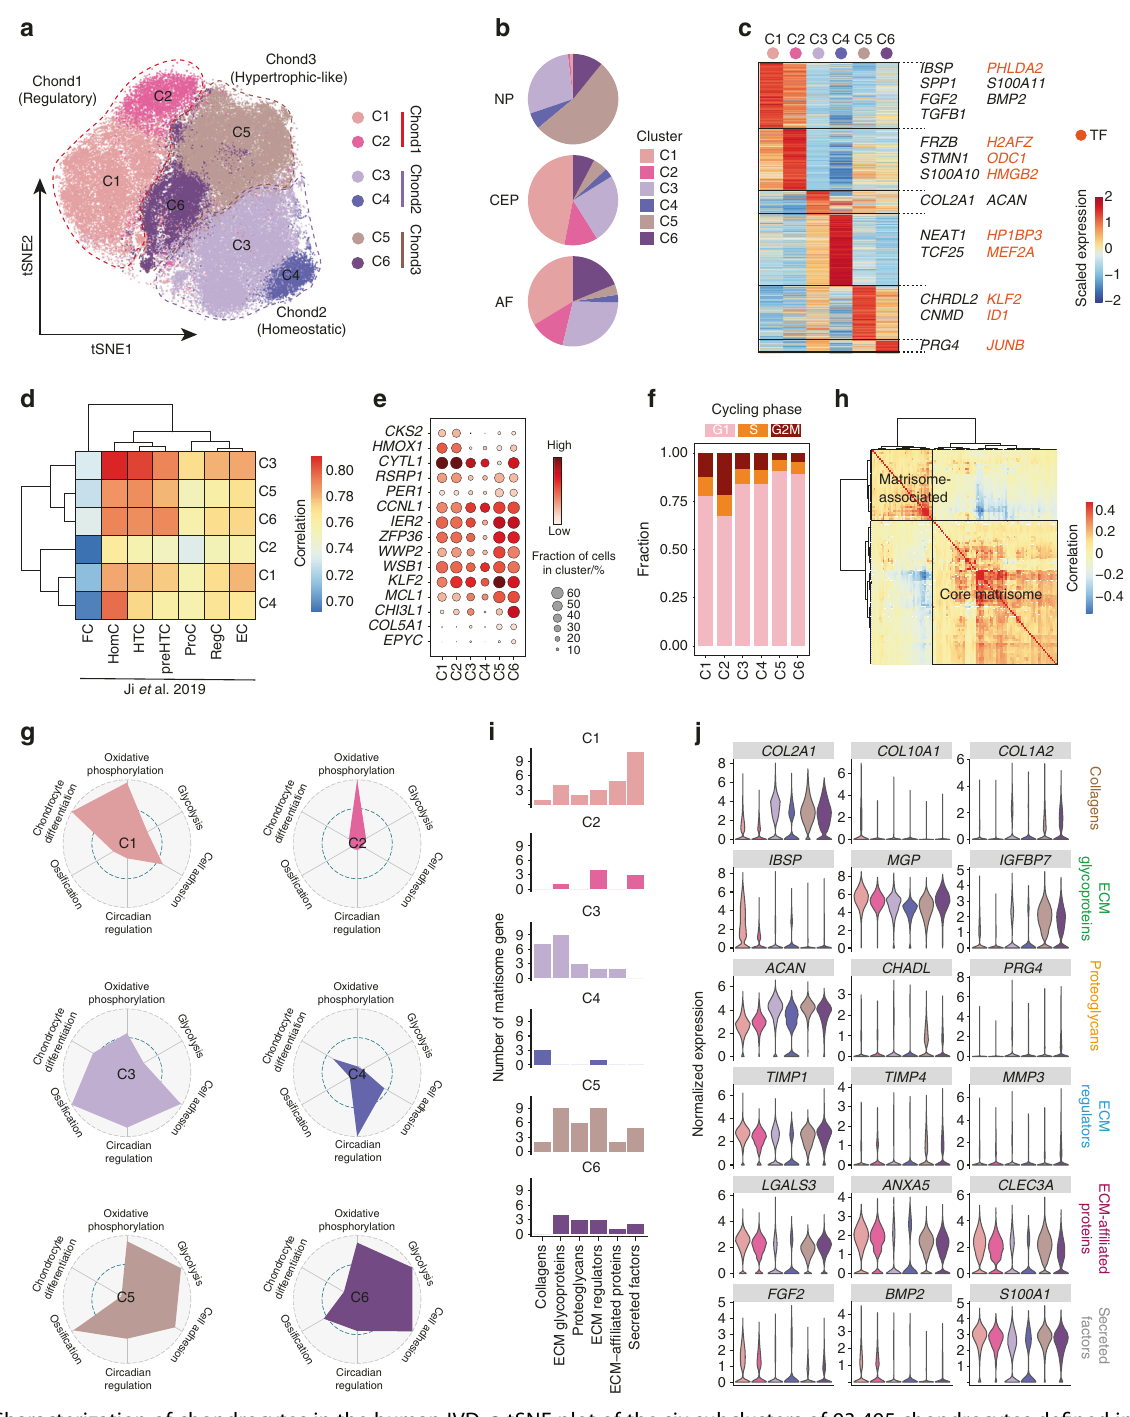
Fig. 2 Characterization of chondrocytes in the human IVD. a tSNE plot of the six subclusters of 93 495 chondrocytes de fi ned in the IVD. b Fraction of each chondrocyte subcluster in the NP, CEP, and AF. c Heatmap revealing the scaled expression of DEGs for each chondrocyte subcluster. d Heatmap showing pairwise Pearson correlations in the global transcriptome between IVD chondrocytes and articular chondrocytes (Ji et al., 51 ). FC fi brocartilage chondrocyte, HomC homeostatic chondrocyte, HTC hypertrophic chondrocyte, preHTC prehypertrophic chondrocyte, ProC proliferative chondrocyte, RegC regulatory chondrocyte, EC effector chondrocyte. e Dot plot showing the mean expression of selected chondrocyte function-associated genes among the six chondrocyte subclusters. Dot size indicates the percentage of cells in subclusters with detected expression. f The fraction of each chondrocyte subcluster arrested in the different cell-cycle phases. g Radar map showing the performance of six gene sets associated with the indicated function and metabolic pathway among each chondrocyte subcluster. h Heatmap showing pairwise Pearson correlations of expressed matrisome genes in chondrocytes. Two signature patterns (matrisome-associated and core matrisome) were identi fi ed by hierarchical clustering. i The number of expressed genes associated with six matrisome patterns in each chondrocyte subcluster. ECM extracellular matrix. j Violin plots showing the expression levels of representative genes associated with six matrisome patterns in each chondrocyte